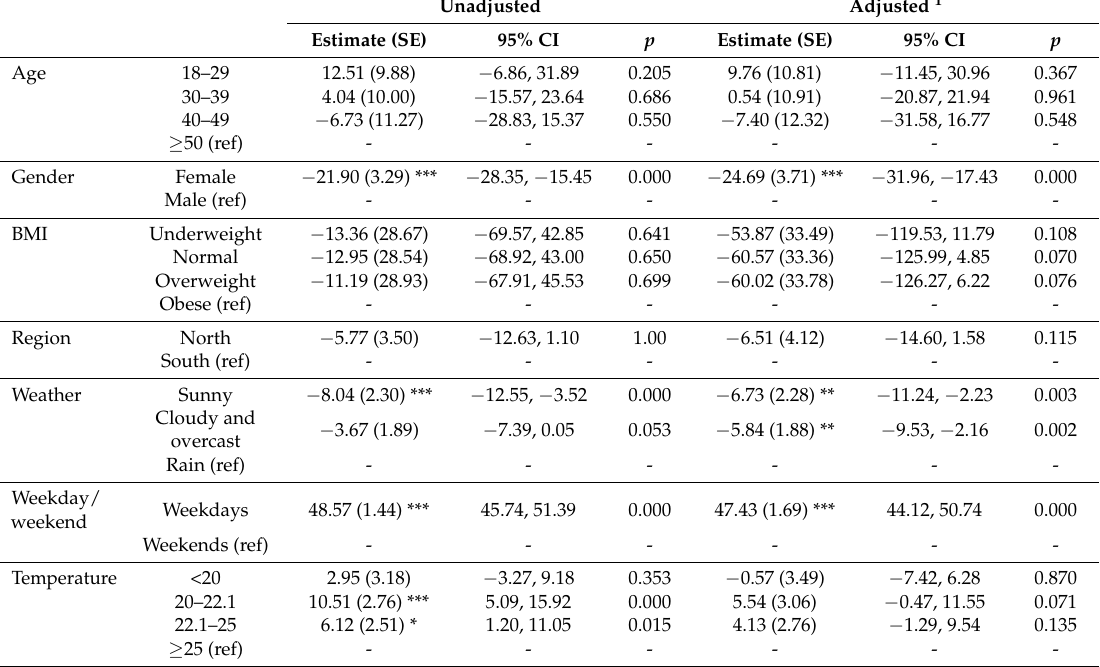
Table 2. Associations between sedentary time (minutes) and potential